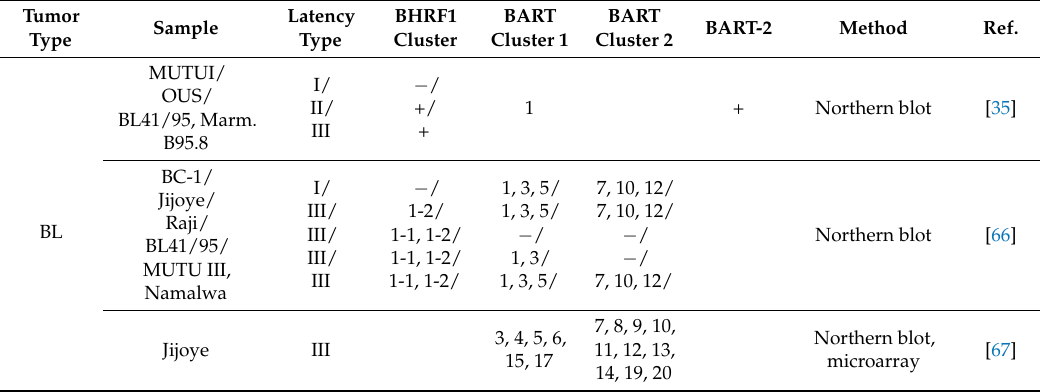
Table 1. EBV encoded miRNA expression in associated